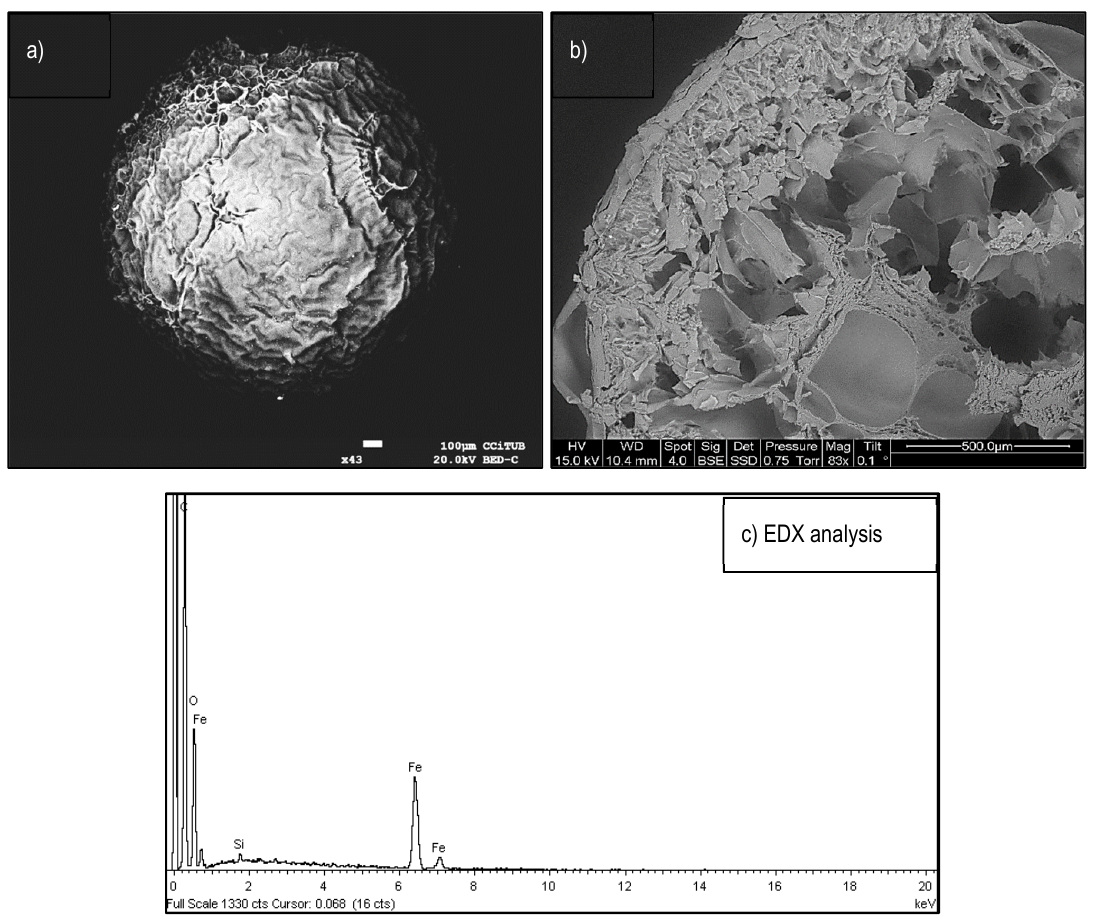
Figure 2. Scanning electron microscopy (SEM) observations. ( a ) Bead photo of ChiFer(III). ( b ) ChiFer(III) segment. ( c ) Energy-dispersive x-ray (EDX) spectra.